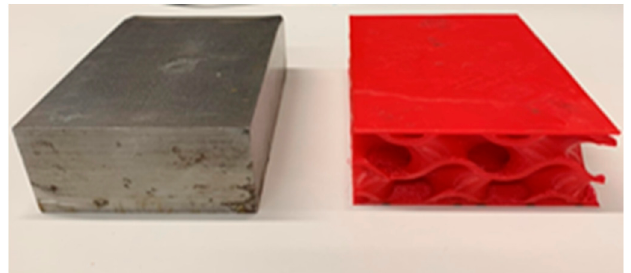
Figure 2. Thick steel plate specimen and the 3D-printed TPU gyroid specimen.